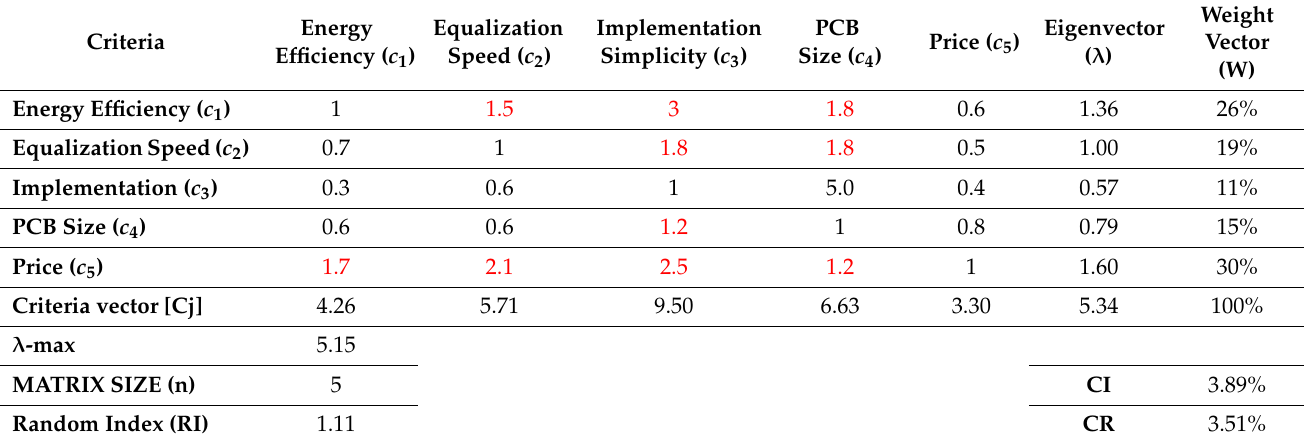
Table 5. AHP Survey general pairwise comparison matrix A